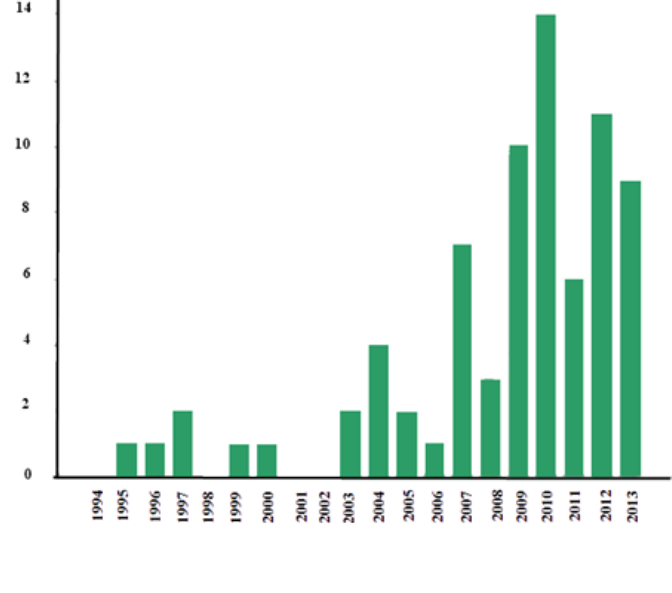
Figure 2. Graph of computer application and autism